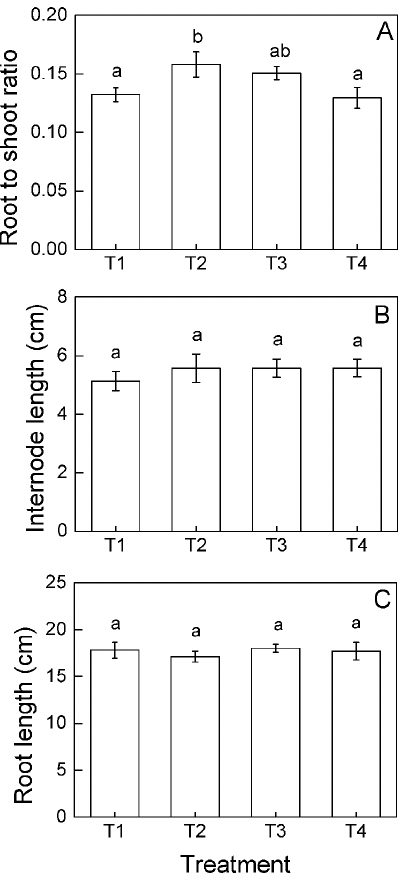
Figure 3. Responses of root to shoot ratio and morphological characters of Buchloedactyloides to heterogeneous nutrients at genet level. Mean values ( 6 S. E.) of root to shoot ratio (A), internode length (B) and root length (C) are given. Bars sharing the same letters are not different at p =0.05. Treatment codes are in Figure 1.